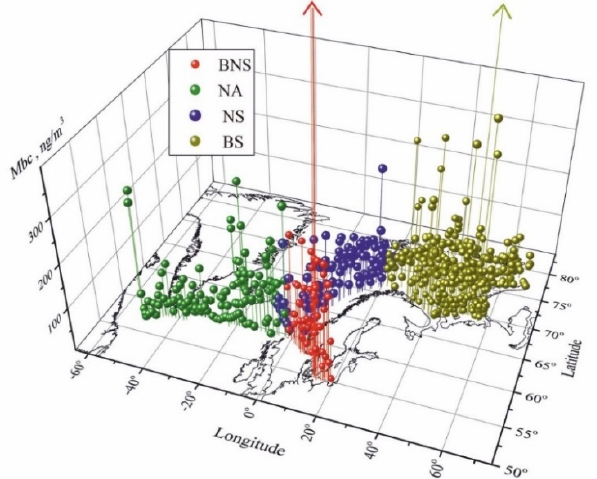
Figure 4. Variations in black carbon concentrations in different regions: BNS—Baltic and North Seas; NA—North Atlantic; NS—Norwegian Sea; BS—Barents Sea.